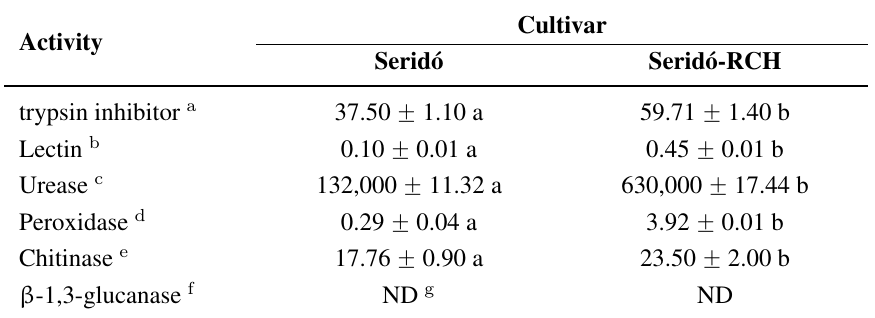
Table 2. Biological activities present in the crude extracts of soybean cultivars *.